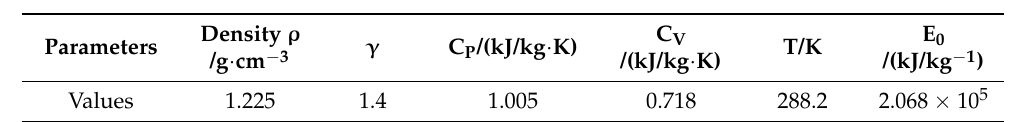
Table 4. Material parameters of AIR [21].